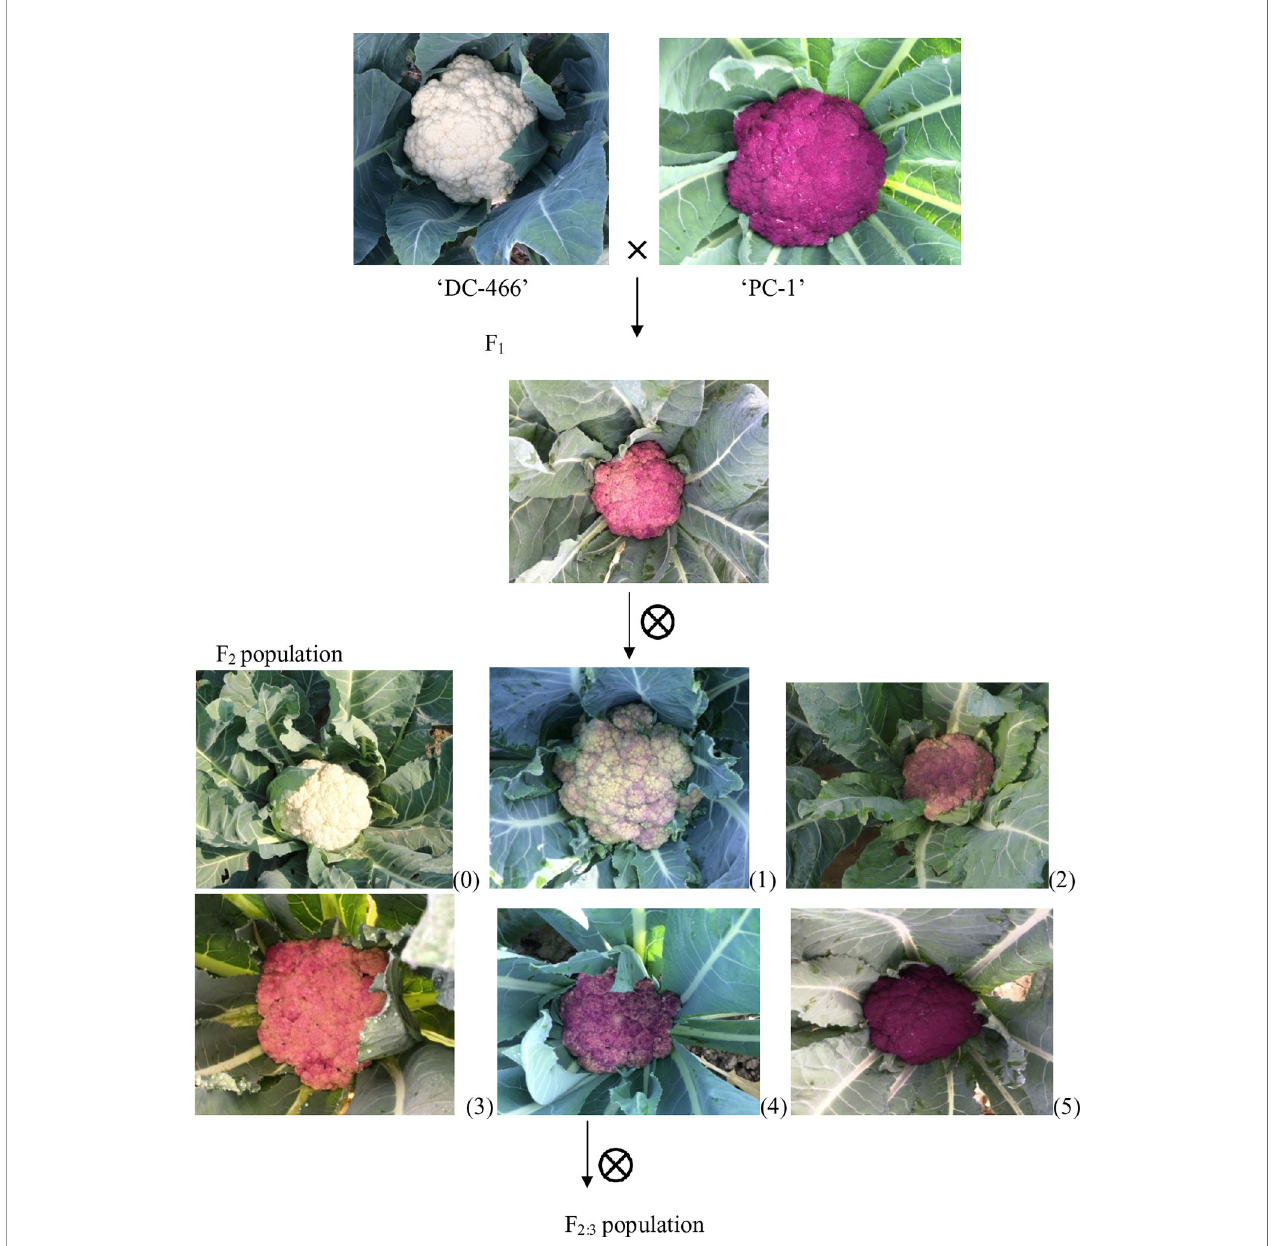
FIGURE 3 | Observed curd color phenotypes of parents, F 1 , and F 2 population. Curd color scale of ‘ 0 – 5'; 0 = white, 1 – 4 = light to intermediate purple; 5 = intense